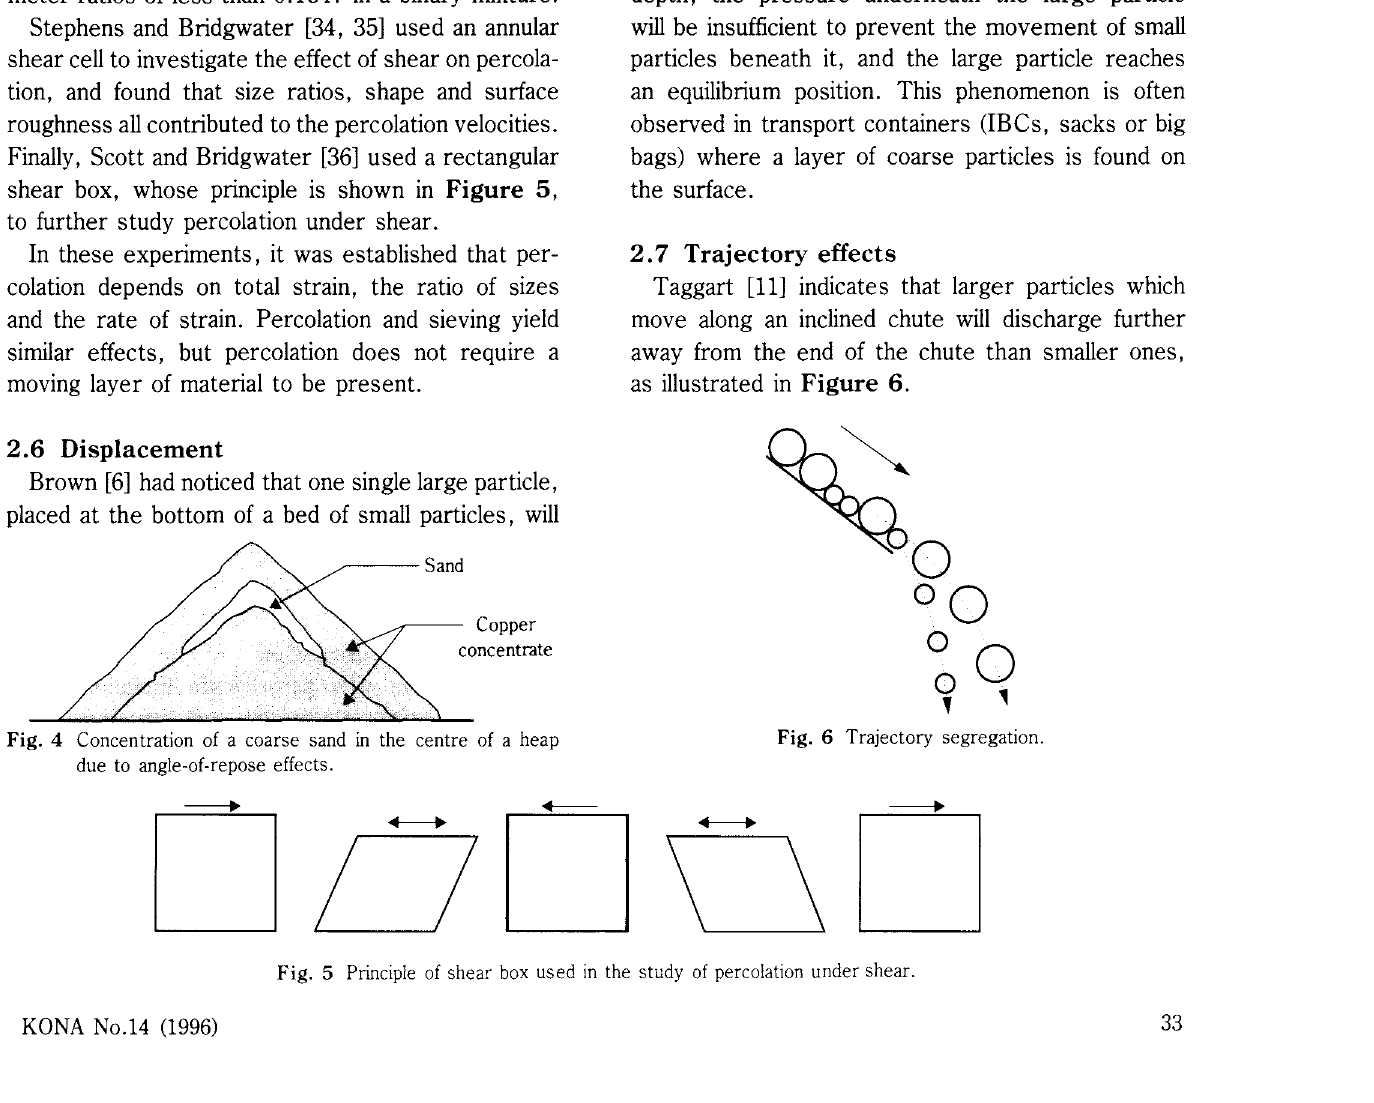
Fig. 6 Trajectory segregation.